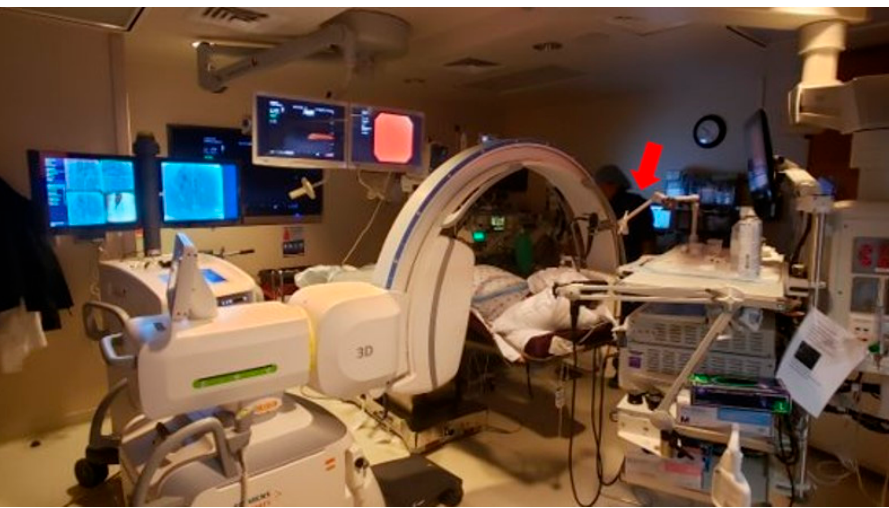
Figure 1. Bronchoscopy suite set up with m-CBCT. The red arrow corresponds to the metallic arm holding the bronchoscope during cone beam CT